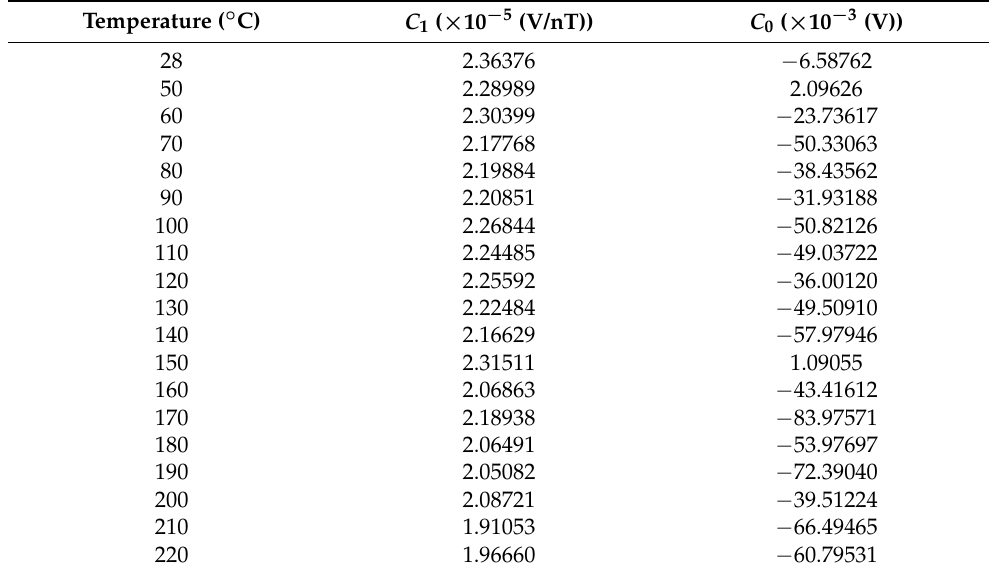
Table A1. Normalized parameters of temperature calibration test of all 19 temperatures. The parameters in the table correspond to ˆ U S = C 1 · B A − C 0